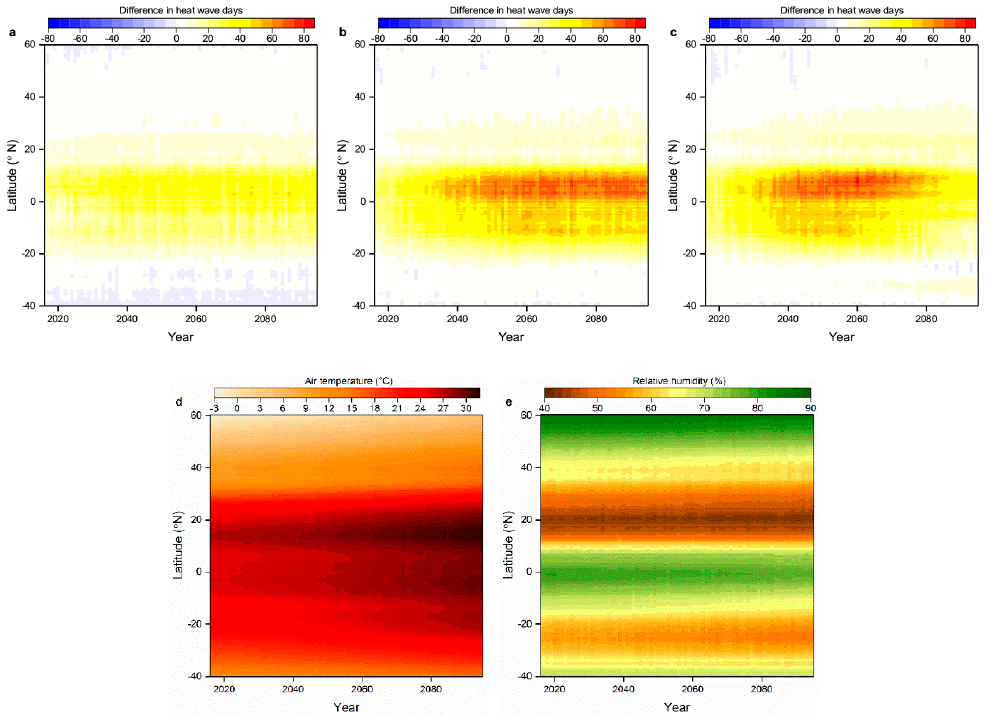
Figure 4. Temporal changes with latitude in the difference in the number of annual WHWDs and THWDs over land under ( a ) RCP2.6, ( b ) RCP4.5, and ( c ) RCP8.5. ( d ) Mean air temperature and ( e ) relative humidity under RCP8.5 were also simulated. Results are based on the multi-model averages during 2016–2095.